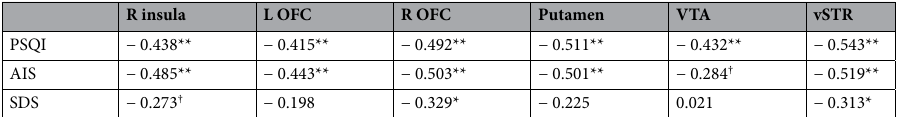
Table 3. Correlation matrix analyses between the brain activity and scales of insomnia and depression. L left side, R right side, OFC orbitofrontal cortex, VTA ventral tegmental area, vSTR ventral striatum, PSQI The Pittsburgh Sleep Quality Index, AIS Athens Insomnia Scale, SDS Self-Rating Depression Scale. † p <